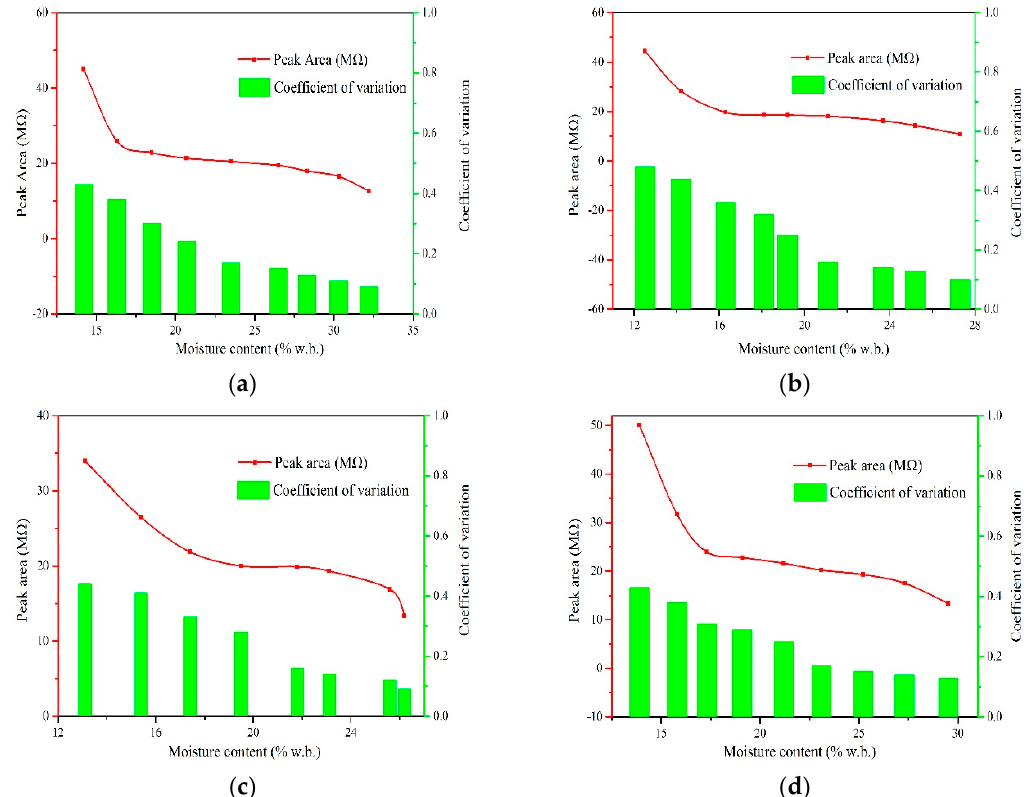
Figure 11. Peak area of waveforms of four species with different moisture contents. ( a ) Xiangzaoxian 45; ( b ) Lumai 21; ( c ) Longpimai 2; ( d ) Nanjing 9108.